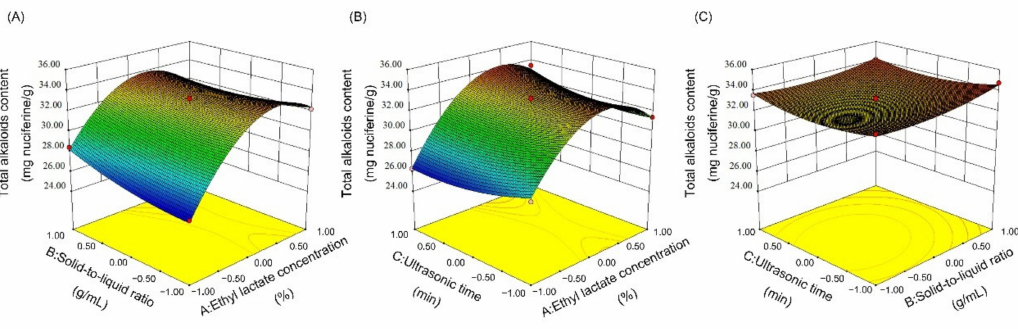
Figure 2. 3D response surface of the total alkaloid content affected by the interaction between ( A ) ethyl lactate concentration and solid-to-liquid ratio, ( B ) ethyl lactate concentration and ultrasonic time and ( C ) solid-to-liquid ratio and ultrasonic